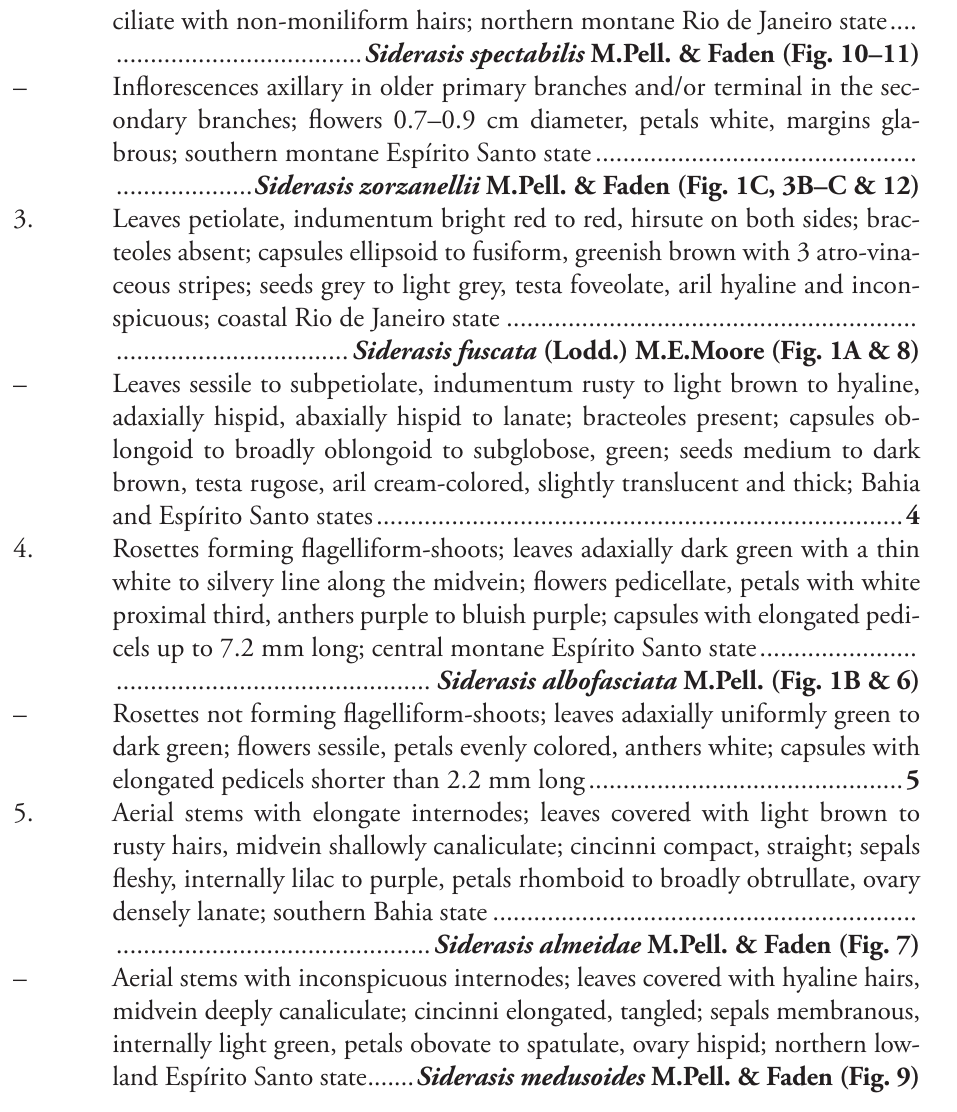
1. Siderasis albofasciata M.Pell., Nordic J. Bot. 35(1): 30. 2017. Figs 1B, 2, 6 Type. BRAZIL. Espírito Santo: Santa Teresa, Alto do Julião, Fazenda Novo Triunfo, property of Mrs. Florinda, gallery forest with rocky formations, above the dam, fl., fr., 18 Apr 2013, M.O.O. Pellegrini et al. 337 (holotype: RB barcode RB00813532!; isotype: